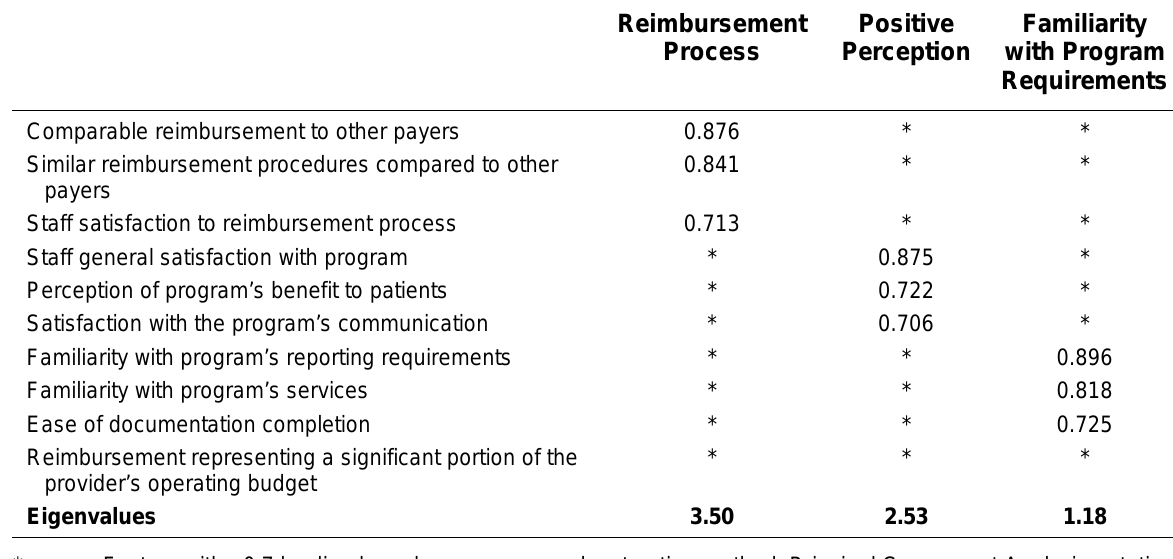
Provider Satisfaction Pattern